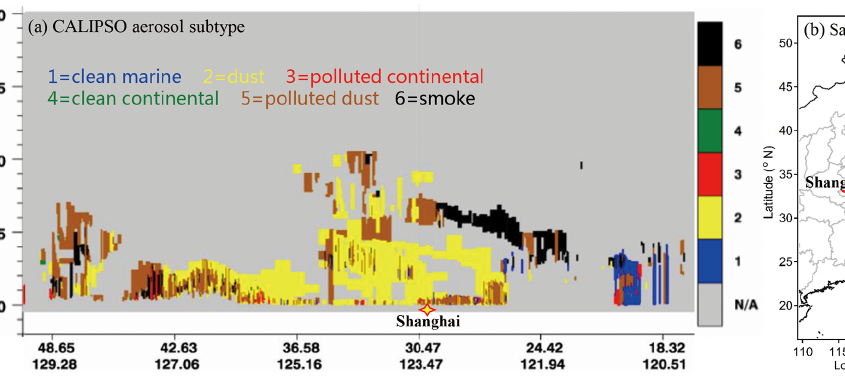
Figure 6. (a) Vertical cross section of aerosol subtype along the (b) CALIPSO satellite track at 02:04LT on 23 March 2015.